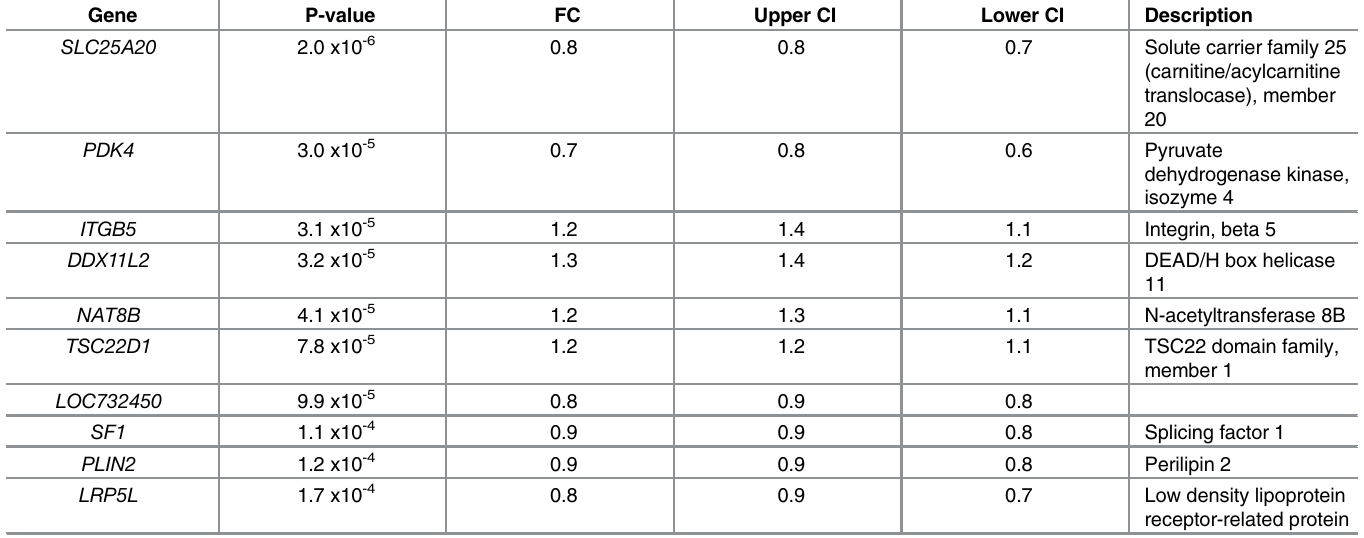
Table 2. Top genes associated with stable sinus rhythm after electrical cardioversion. Fold Change (FC). Confidence Interval (CI).